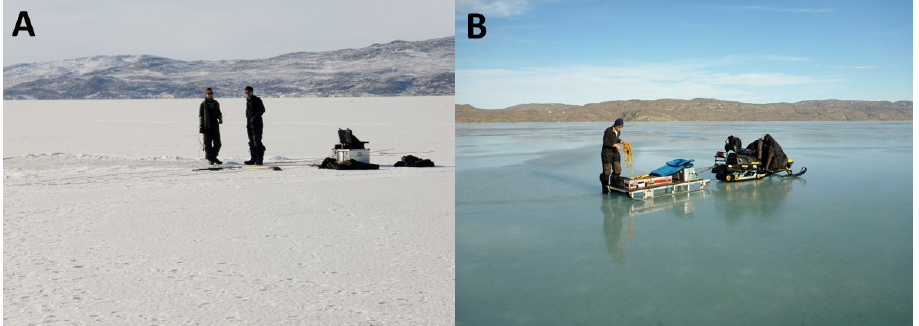
Figure 2. Photos showing change in snow cover on the fjord between ( A ) Day 71 and ( B ) Day 77 of the study due to sudden increase in air temperature and rainfall from Days 74–75 (photos by au- thors).